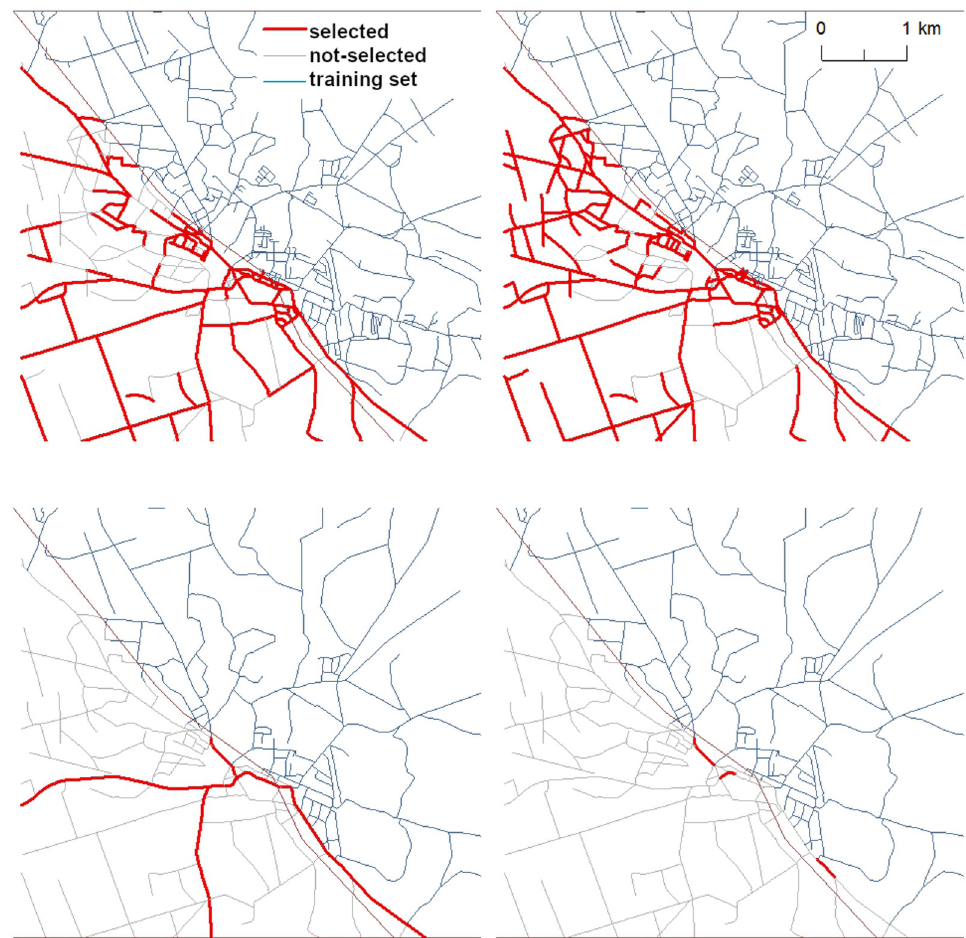
Fig. 7. The results for the road sections obtained by the RST method in the area of Chocianów: on the left − the CN2 algorithm, on the right − the LEM2 algorithm; at the top − 10k→50k selection, at the bottom − 50k→250k selection; the selected objects are marked in red (source: A. Fiedukowicz